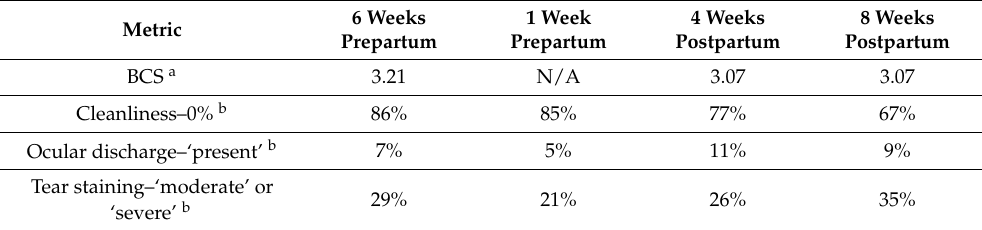
Table 4. Dam physical health at each time